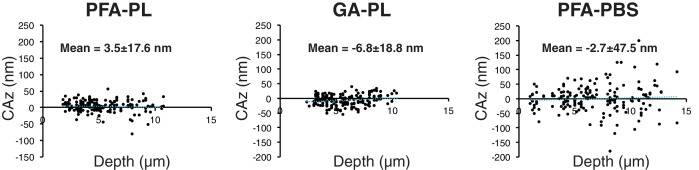
CAz is insensitive to depth in samples mounted with Prolong Gold, but not in samples mounted with PBS.Representative plots of CAz versus depth for experimental conditions in Figure 2A.